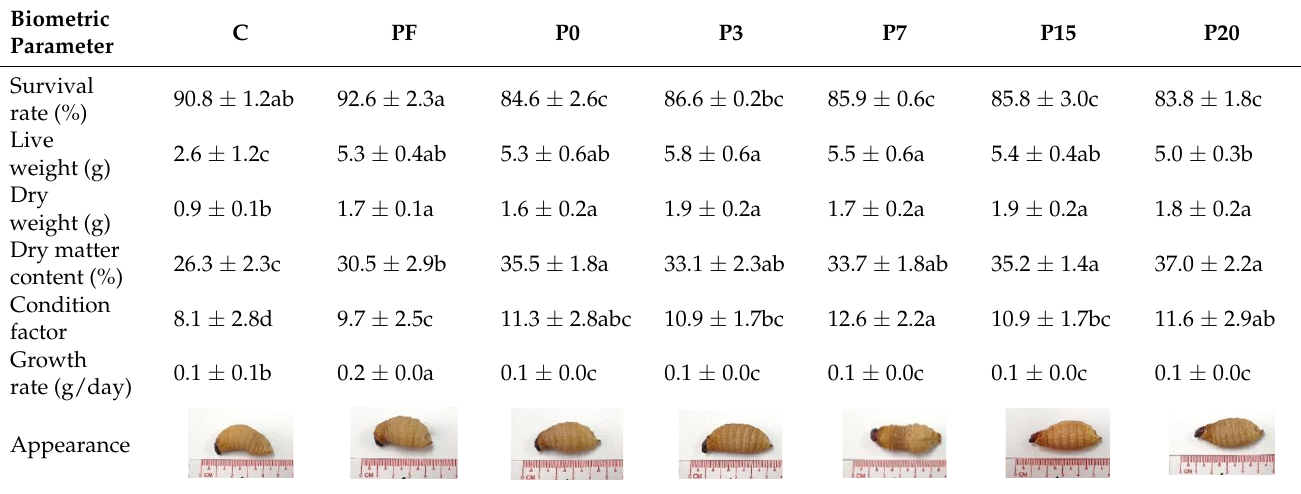
Table 4. Growth performance of sago palm weevil larvae (SPWL) fed with different